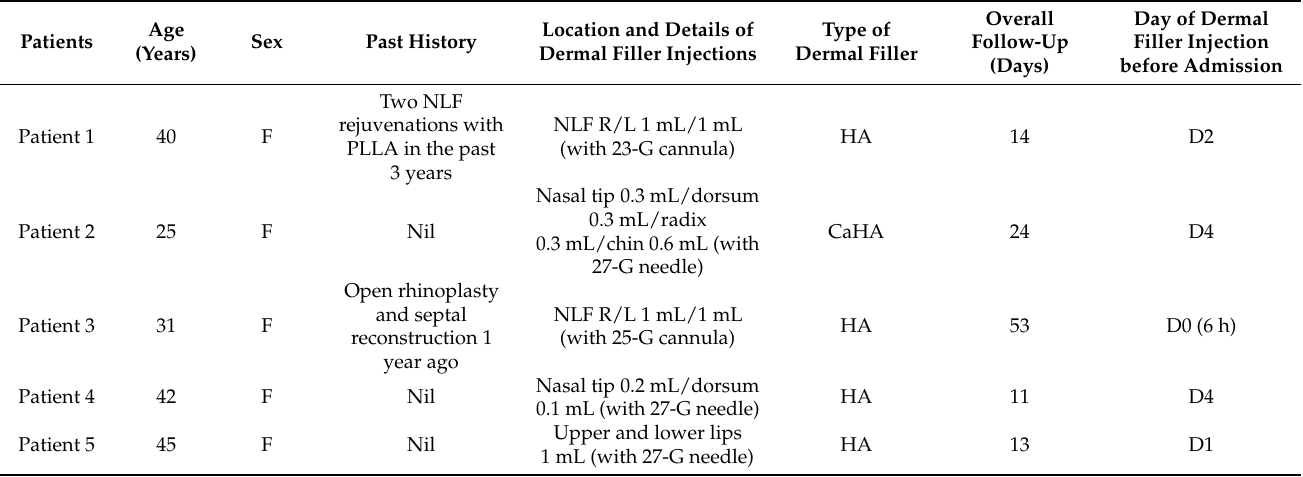
Table 1. Patient demographics and clinical